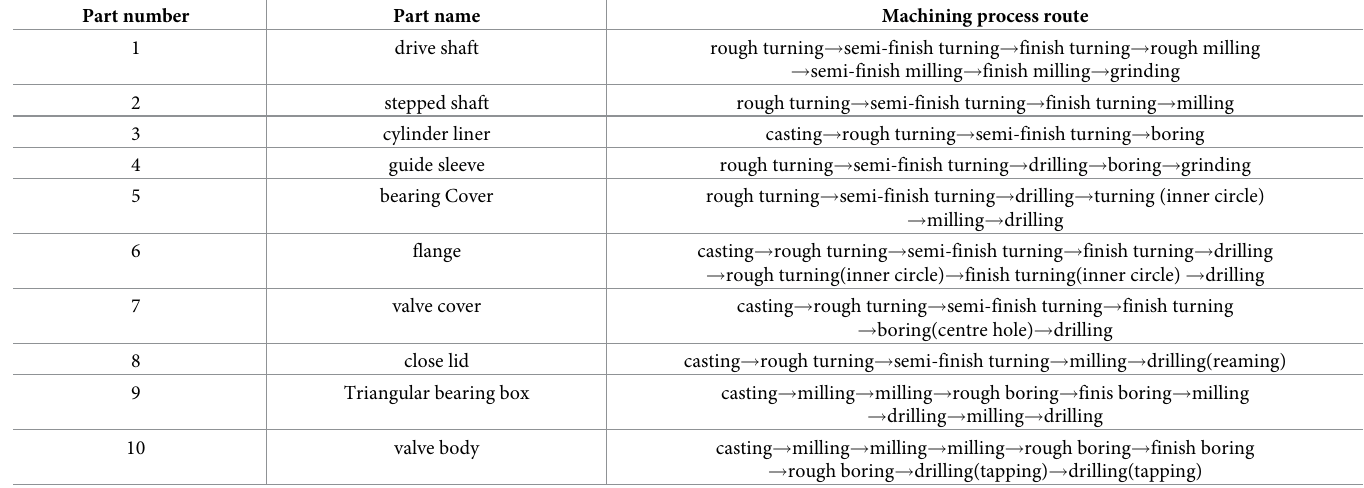
Table 2. The process routes extracted from